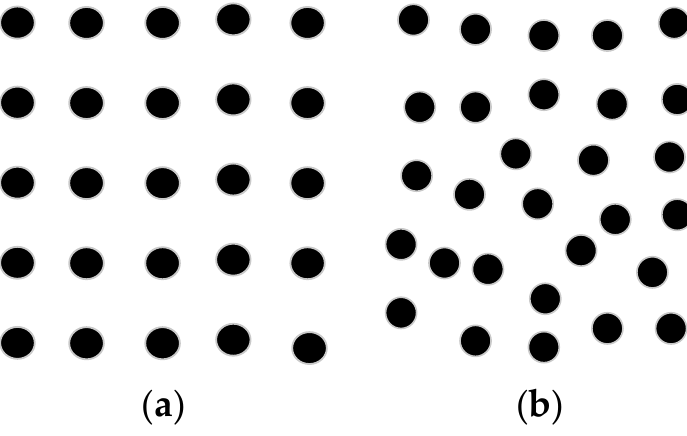
Figure 1. The point cloud data (PCD) classification, ( a ) is regular PCD, ( b ) is irregular PCD.